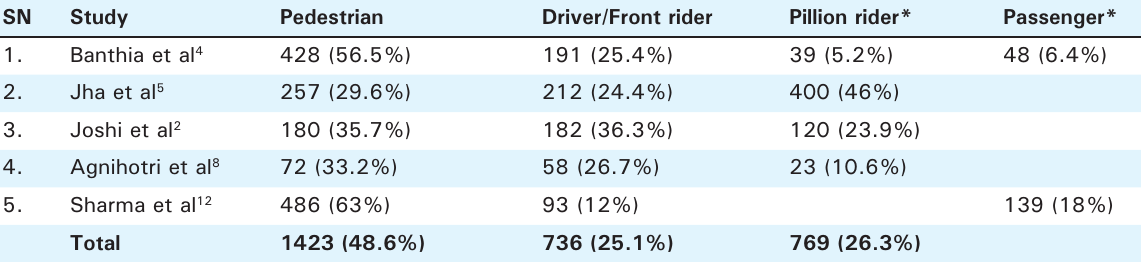
Table 6. Different groups of population involved in